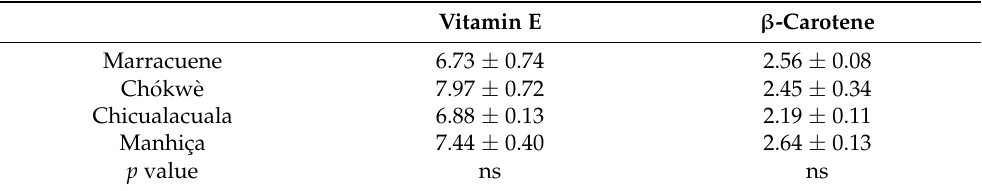
Table 3. Vitamin E and β -carotene contents (mg/100 g) of S. madagascariensis fruit flour ( nfuma ) from four districts (Marracuene, Manhiça, Ch ó kw è and Chicualacuala) of southern Mozambique. Vitamin E β -Carotene Marracuene